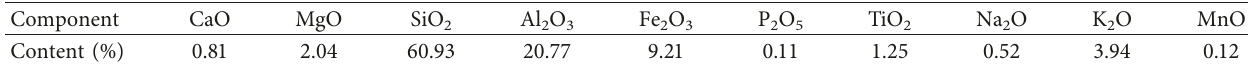
Table 2: Major chemical components of the tested